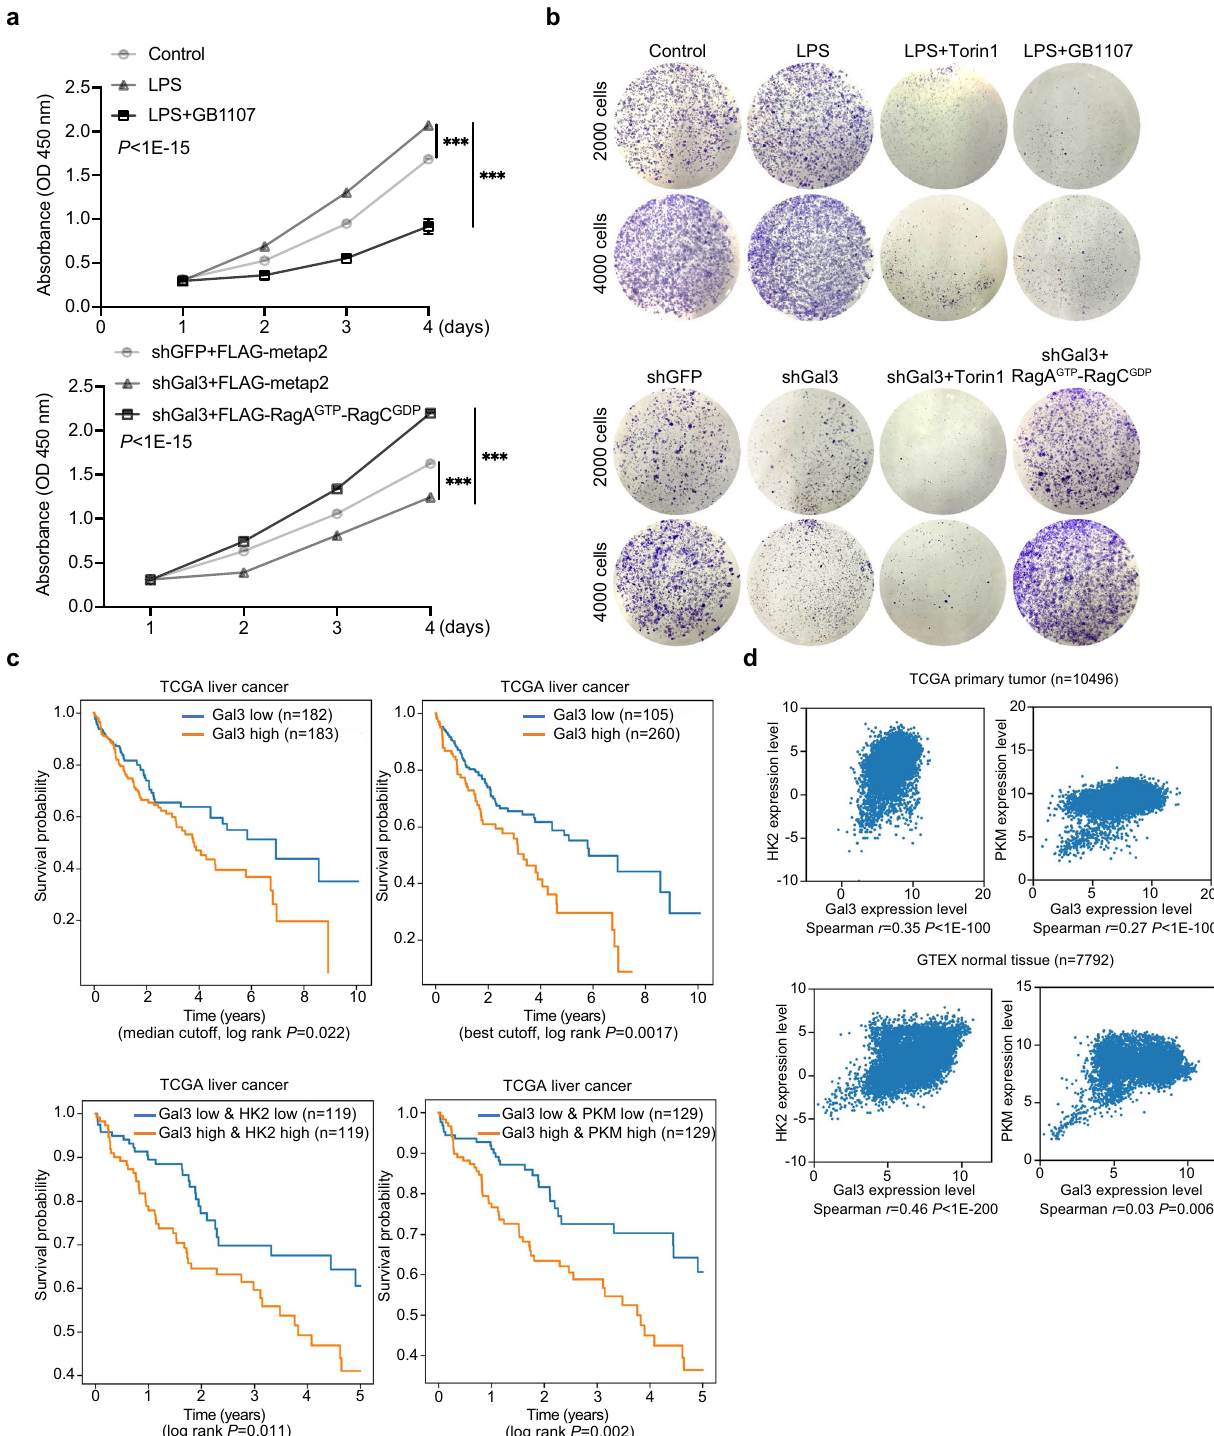
Fig. 7 | Galectin-3 is implicated in hepatocarcinogenesis. a CCK-8 assays for the proliferation of HepG2 cells were treated with LPS or LPS and GB1107, or infected with lentiviruses carrying shGFP or shGal3 and transfected with FLAG-metap2 or FLAG-RagA GTP /RagC GDP . Each bar represents the mean±SD for biological triplicate experiments. P values were calculated by two-way ANOVA (*** P <0.001). b HepG2 cells were treated with LPS, LPS and Torin1, or LPS and GB1107, or infected with lentiviruses carrying shGFP or shGal3 and transfected with FLAG-RagA GTP /RagC GDP in the presence or absence of Torin1 and cultured for 10 days before staining with crystal violet for colony formation assays. Representative images from biological